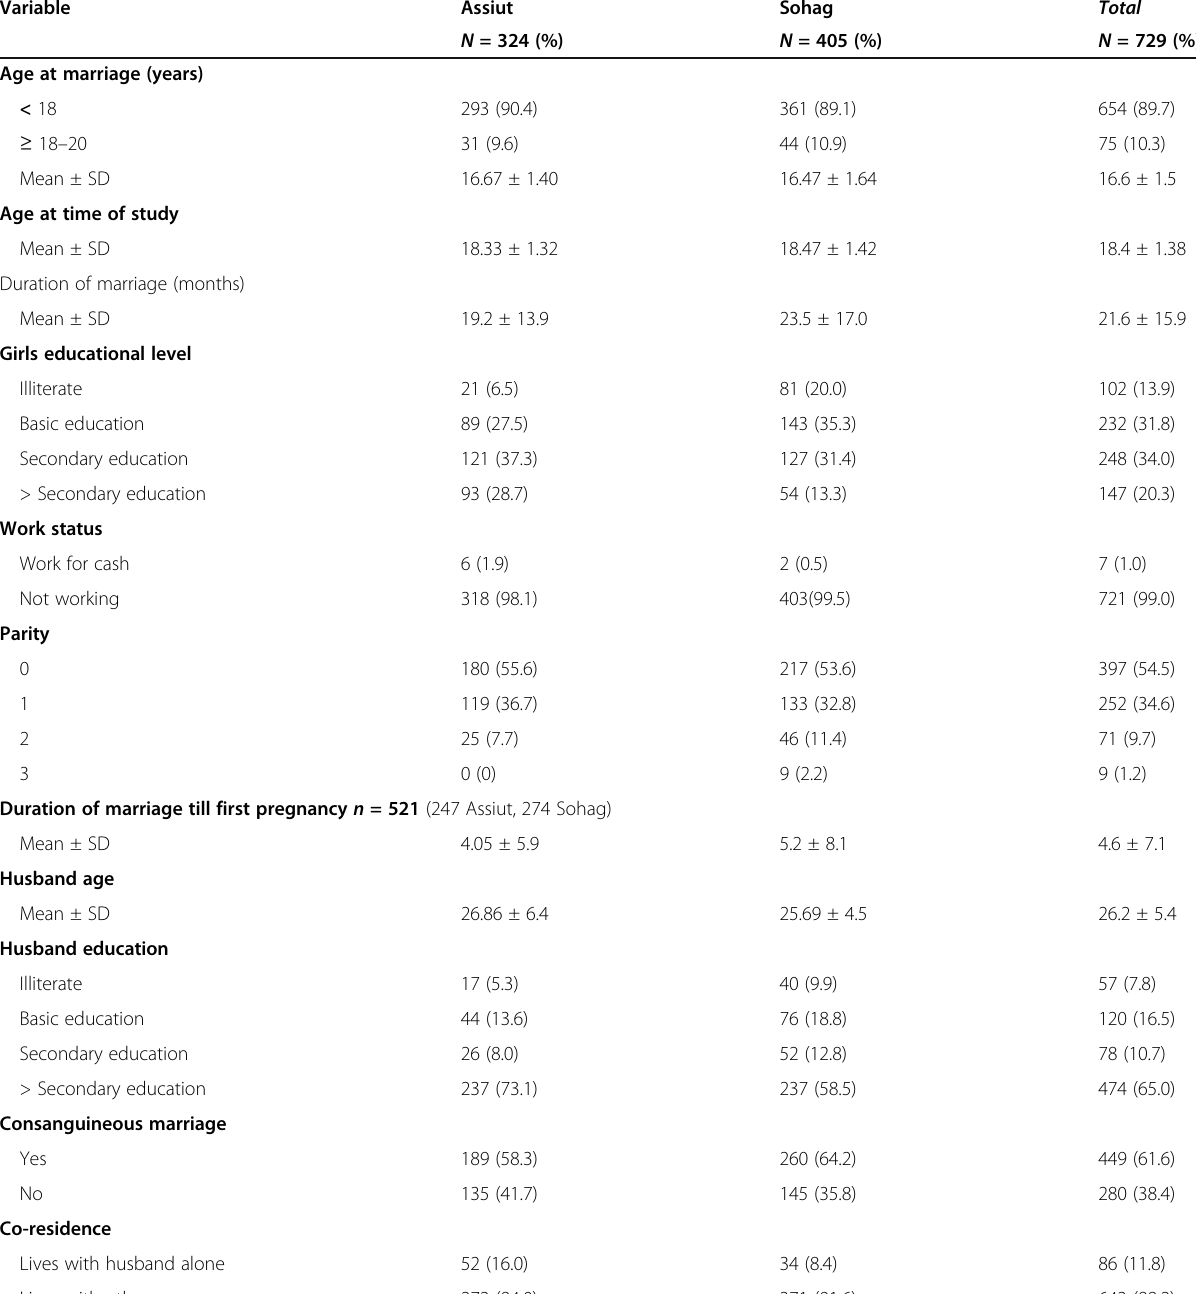
Table 1 Socio-demographic characteristics of the married adolescent girls (MAGs), Upper Egypt Variable Assiut Sohag